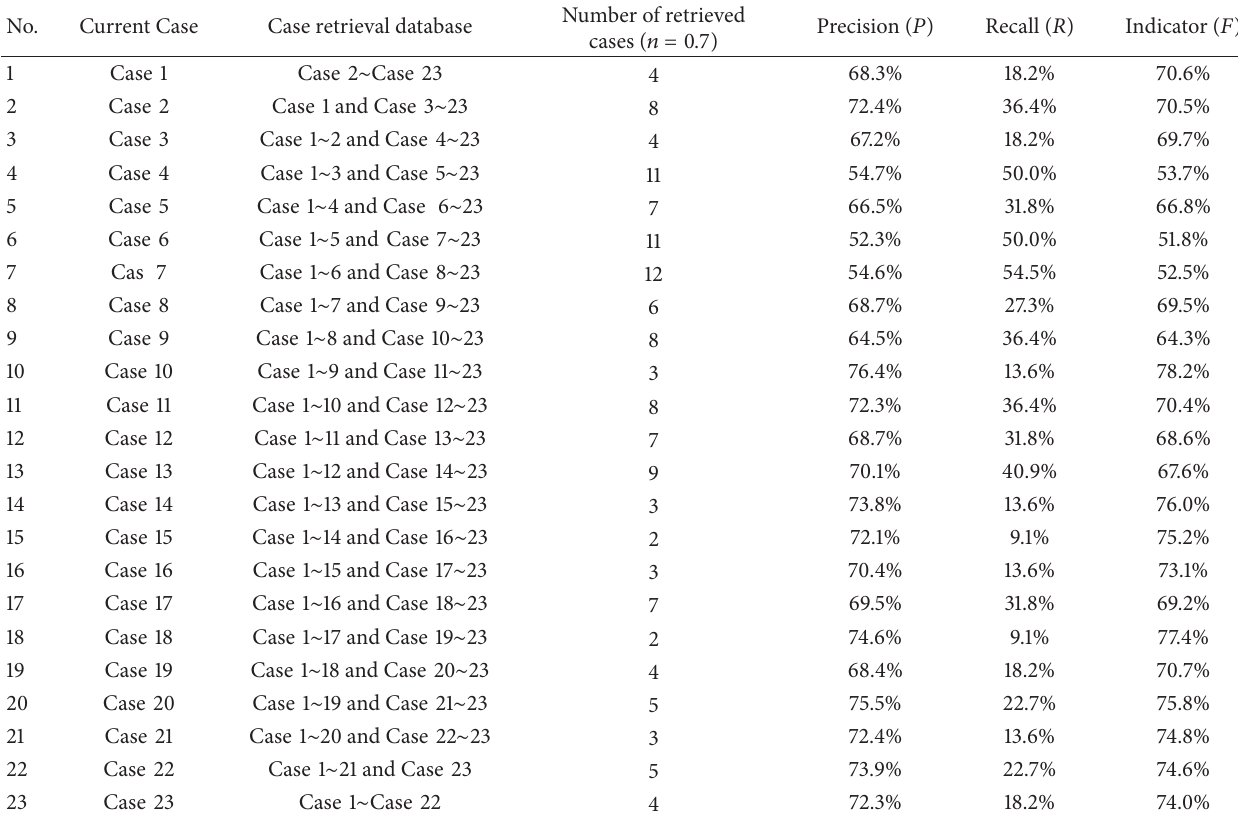
Table 3: Performance of Case-Based Reasoning and Bayesian